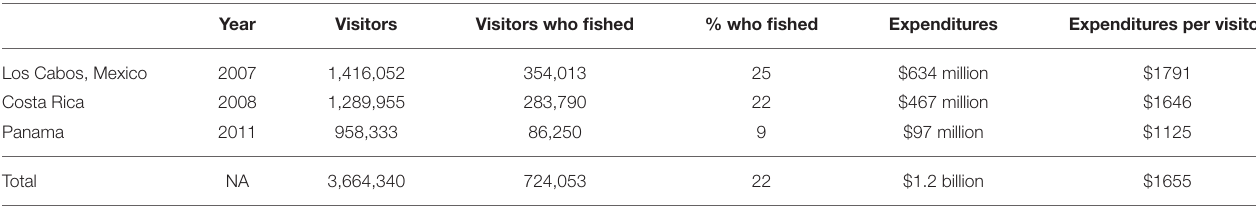
TABLE 2 | Summary data from economic studies of sport fishing in three popular Latin American fishing destinations. Year